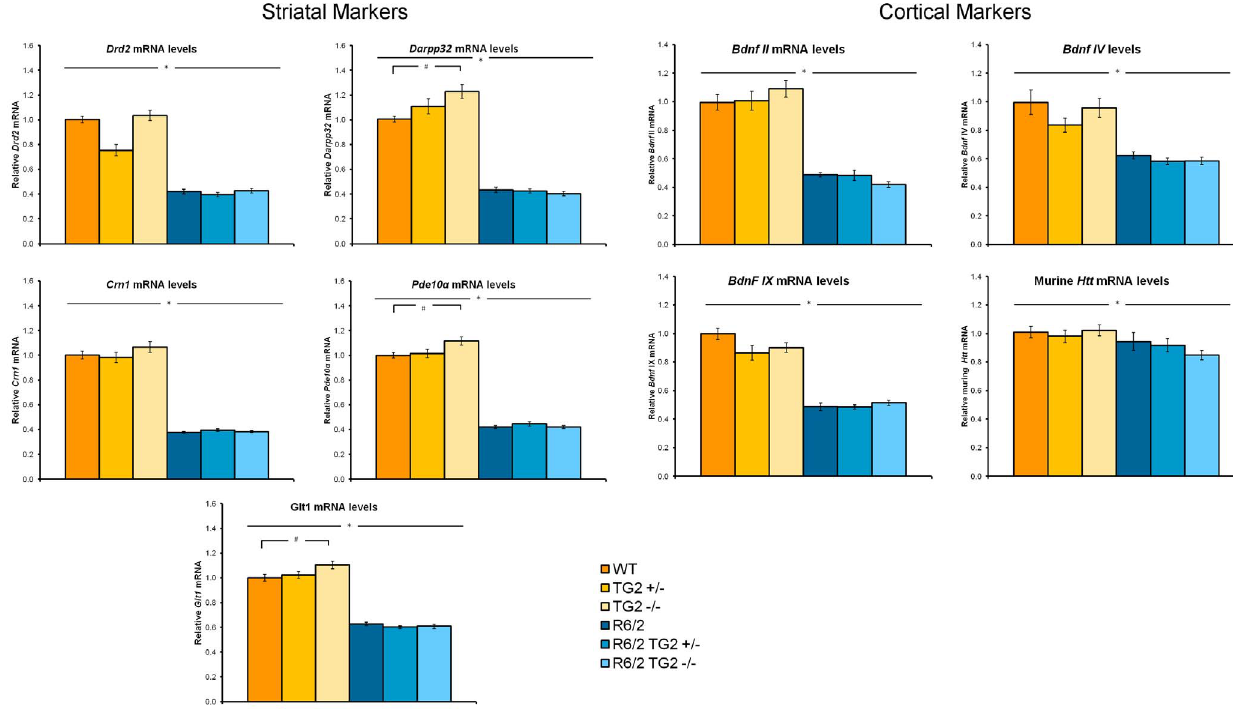
Figure 11. The relative striatal (left panels) and cortical (right panels) mRNA expression level of mice examined from the R6/2 6 TG2 KO line at 12 weeks of age (n=12 per genotype). Relative mRNA levels are normalized to WT controls. For normalization, the geometric means of Ubc , Eif4a2 an Atp5b were used. *Significant HD Genotype effect; # significant TG2 Genotype effect. WT: wild-type, TG2 + / 2 : heterozygous TG2 knockout, TG2 2 / 2 : homozygous TG2